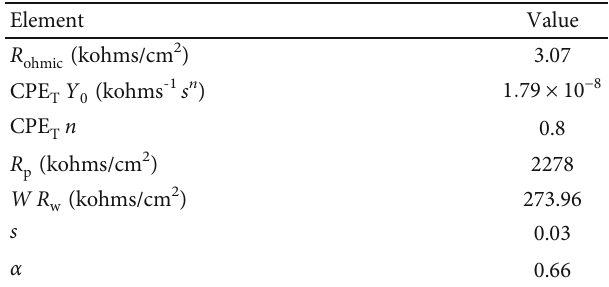
Table 4: Fitting parameters for EIS spectrum of the devices. Element